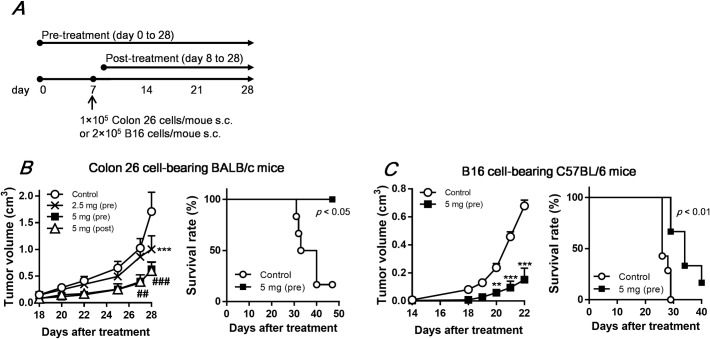
YM-2A provides therapeutic benefit in colon-26 tumor-bearing mice.(A) Experimental scheme. YM-2A (2.5 mg or 5 mg/mouse) was orally administered (daily, 5 days/week) from day 0 (pre-treatment) or day 8 (post-treatment). (B and C, left) Tumor volume (n = 5 for colon26 model, n = 6~7 for B16 model) represents the means ± S.E. of two separate experiments. **p < 0.01 and ***p < 0.001, compared with control. ##p < 0.01 and ###p < 0.001 indicate significant differences both in 5 mg (pre) vs control and 5 mg (post) vs control. (B and C, right) Mice were euthanized when subcutaneous tumors reached 2.25 cm3. Survival rates are represented using Kaplan–Meier curves.